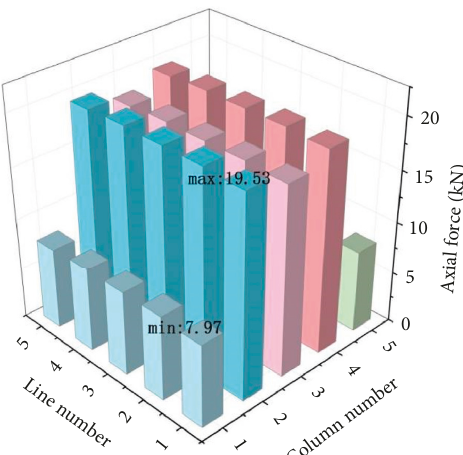
Figure 7: Schematic diagram of the axial force of 25 vertical poles when there is no installation gap at the top.